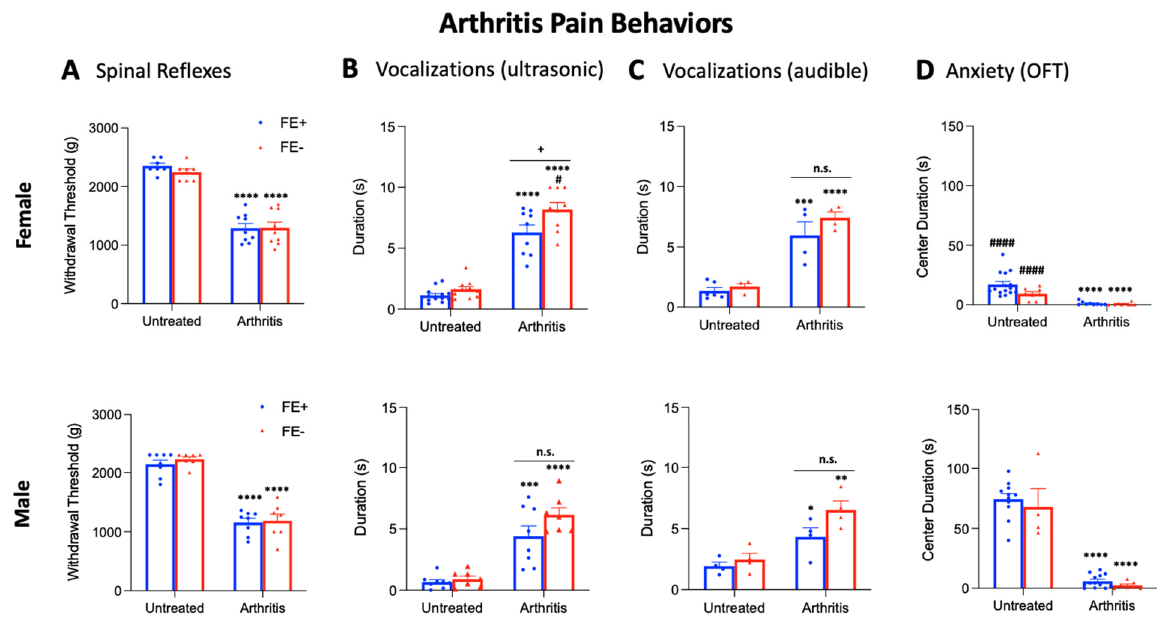
Figure 3. Inter-individual and sex differences in arthritis pain-related behaviors of FE+ and FE − rats. ( A ) Mechanical thresholds tested in untreated control rats and arthritic rats (6 h post-induction) showed no significant differences between FE − (female, n = 7; male, n = 7) and FE+ (female, n = 7; male, n = 8) untreated rats or between FE − (female, n = 9; male, n = 7) and FE+ (female, n = 9; male, n = 8) arthritic rats, but arthritic FE − and FE+ rats had significantly lower withdrawal thresholds than their untreated controls. **** p < 0.0001, ANOVA with Bonferroni post hoc tests (see the “Results” section). ( B , C ) Duration (s) of ultrasonic and audible vocalizations, respectively, evoked by a brief (10 s) noxious (1500 g/30 mm 2 ) mechanical compression of the knee. Significant differences in ultrasonic (but not audible) vocalizations were found between FE − ( n = 9) and FE+ ( n = 9) female arthritic rats but not between FE − ( n = 7) and FE+ ( n = 8) male arthritic rats or between untreated FE − (female, n = 11; male, n = 7) and FE+ (female, n = 13; male, n = 8) rats. For both sexes, arthritic rats had significantly increased vocalizations compared to their untreated controls. n.s.: non-significant; + p < 0.05; # p < 0.05; * p < 0.05; ** p < 0.01; *** p < 0.001; **** p < 0.0001, ANOVA with Bonferroni post hoc tests (see the “Results” section). ( D ) Center duration (s) in the OFT was significantly lower in arthritic FE − (female, n = 9; male, n = 7) and FE+ (female, n = 9; male, n = 13) rats compared to the untreated FE − (female, n = 8; male, n = 7) and FE+ (female, n = 15; male, n = 11) control rats. No differences were found between FE − and FE+ rats in the untreated control or arthritic groups for either sex. #### p < 0.0001; **** p < 0.0001, ANOVA with Bonferroni post hoc tests (see the “Results” section). Bar histograms show means ± SEM. FE: fear extinction; OFT: open field test. Asterisk (*) indicates comparison to untreated group; plus sign (+) indicates comparison between phenotypes; pound sign (#) indicates comparison between sexes.